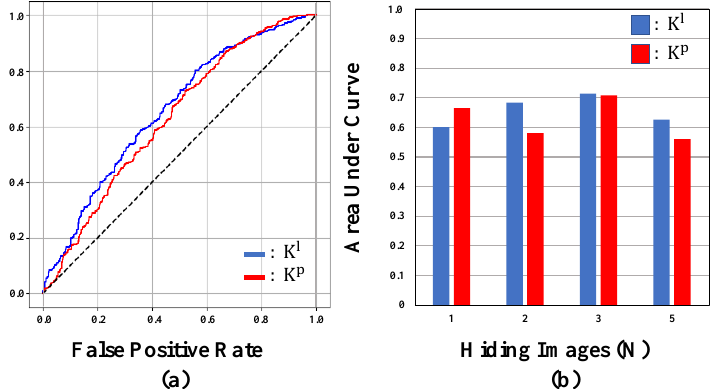
Figure 4. ( a ) ROC curves according to the size of the key. ( b ) Area under the curve (AUC) values according to N (Red: K p , Blue: K l ).